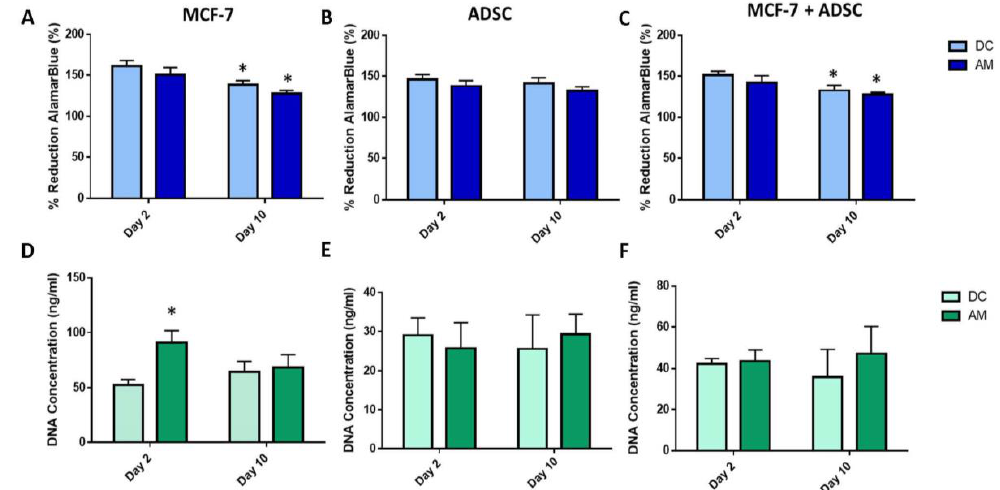
Figure 4. Cancer cell and adipocyte cell metabolic activity (as indicated by percent reduction alamarBlue ® reagent) in monoculture ( A , B ) and co-culture ( C ) in 2D monolayer culture. DNA content as measured using PicoGreen ® assay for MCF-7 cancer cells ( D ) and adipocytes ( E ) in monoculture and co-culture ( F ). Asterisks (*) indicate a statistically significant difference ( p < 0.05). Gels 2020 , 6 , x FOR PEER REVIEW